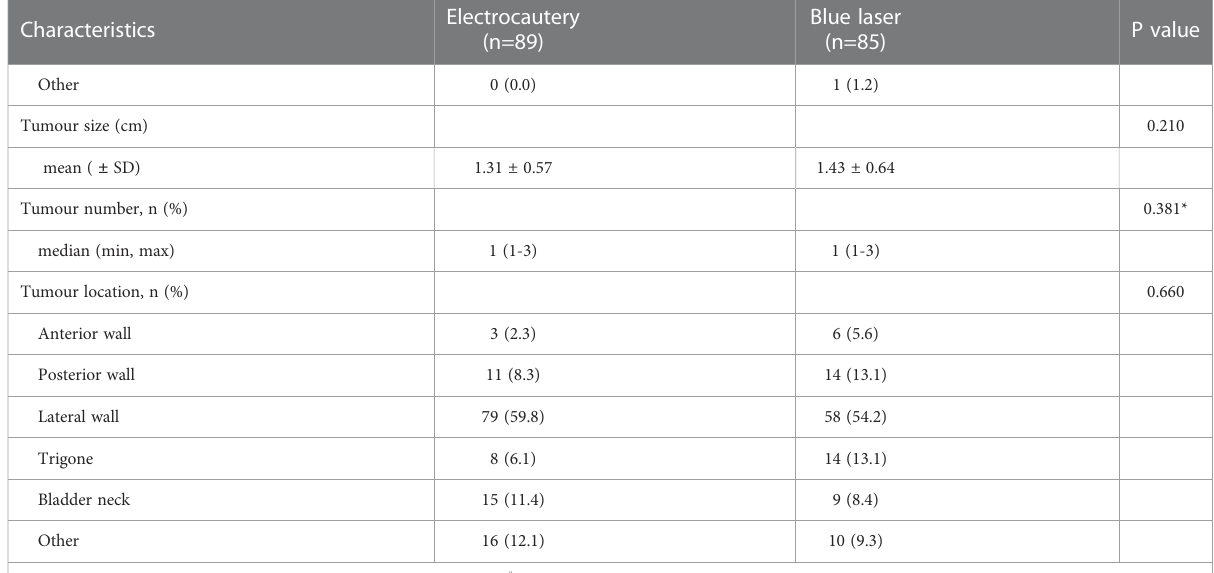
one subject in the blue laser group required a second surgery to stop active intravesical bleeding and evacuate blood clot